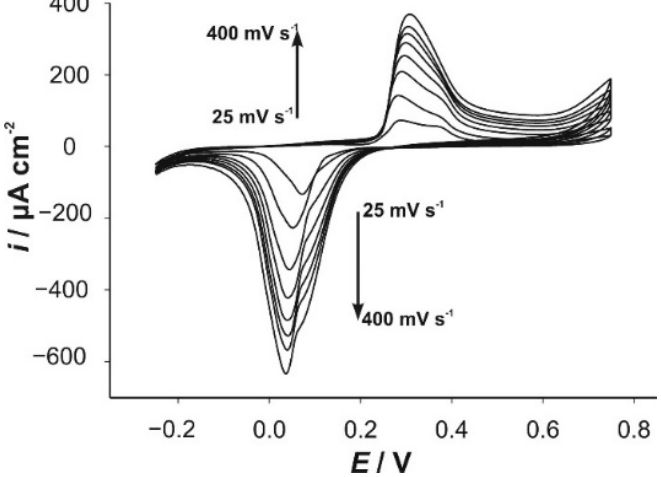
Figure 2. Cyclic voltammograms recorded in 0.1 M acetate buffer solution at pH 5, with the CPE modified with 5% of the material, at different scan rates: 25, 50, 100, 150, 200, 250, 300 and 400 mV s − 1 .